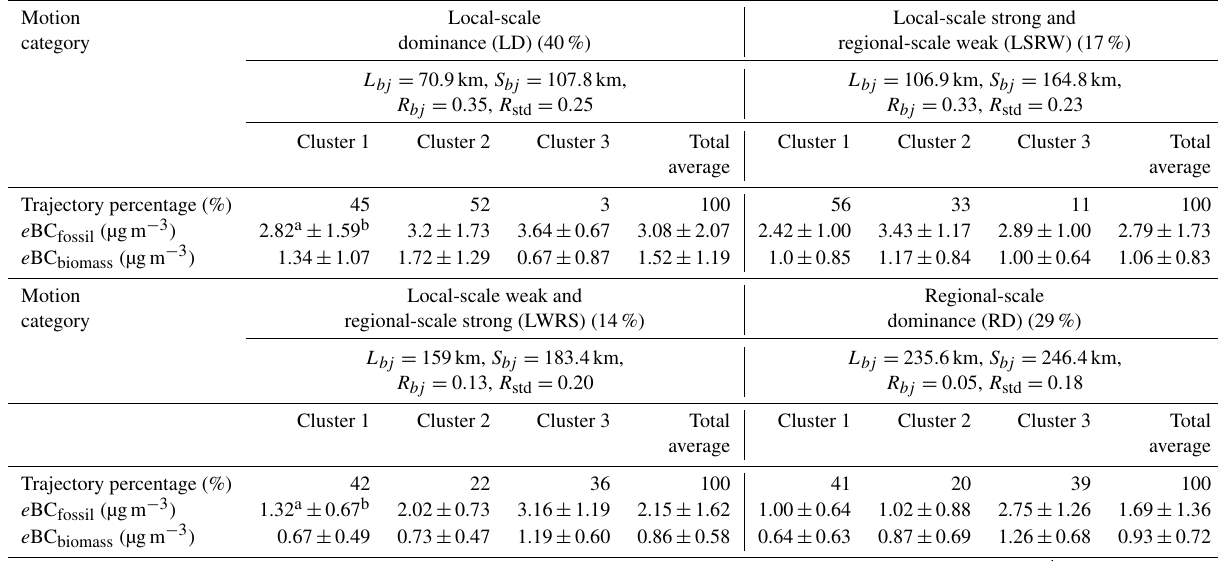
Table 1. The mass concentration of e BC from fossil fuel combustion ( e BC fossil ) and e BC from biomass burning ( e BC biomass ) associated with different clusters under four featured atmospheric motions.